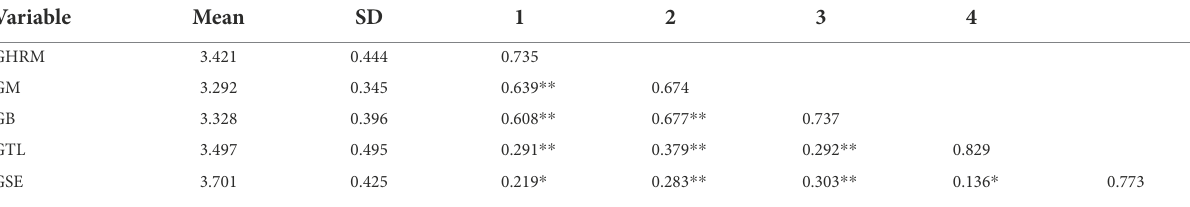
TABLE 3 Mean value, standard deviation and correlation coefficient of each variable (N = 296).